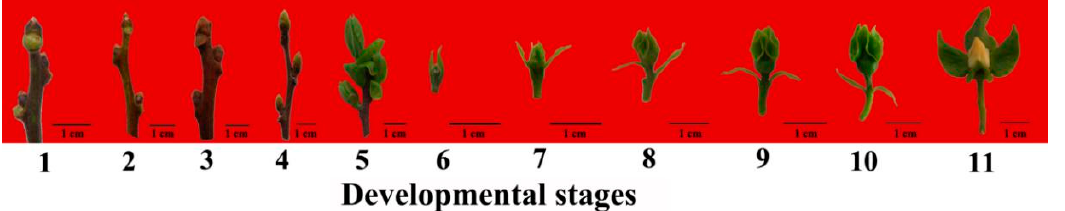
Figure 2. Female floral buds at different developmental stages (1–11).